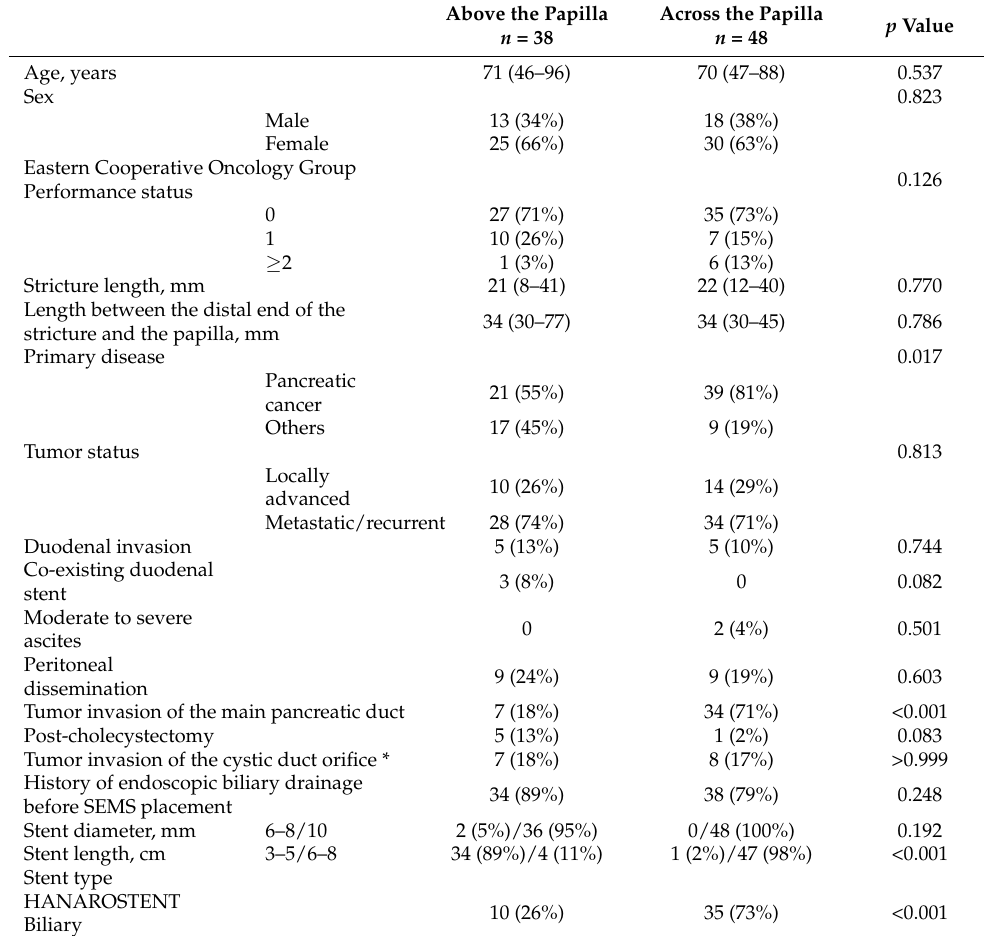
Table 1. Baseline and procedural characteristics of patients who received covered metal stent above the papilla and across the papilla.